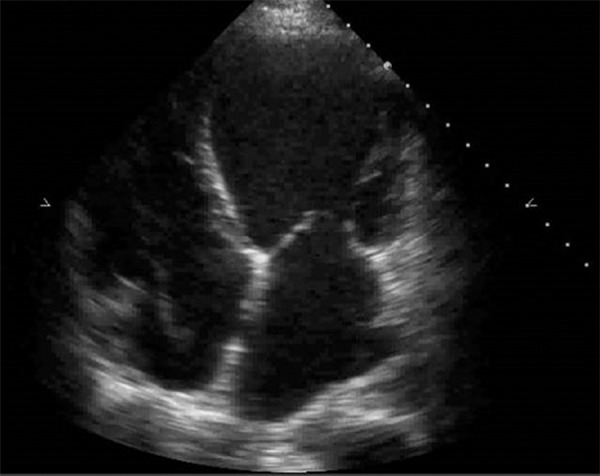
Dilated cardiomyopathy.